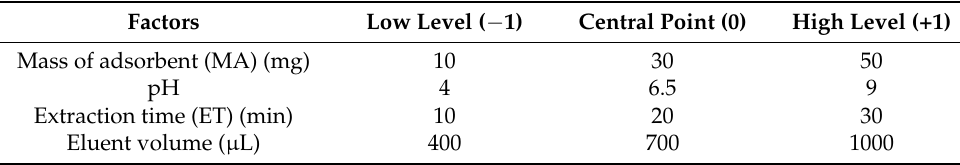
Table 1. Parameter and levels used in central composite experimental design. Factors Low Level ( − 1) Central Point (0) High Level (+1) Mass of adsorbent (MA)